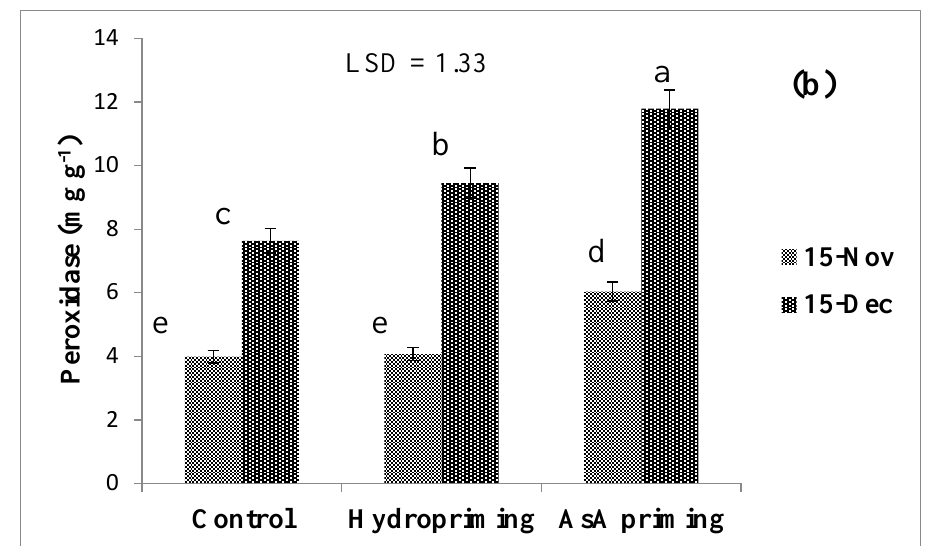
Figure 5. ( a , b ) Interaction between priming techniques and sowing dates for peroxidase during 2016-17. Means not sharing same letter (s) differ significantly at p ≤ 0.05.